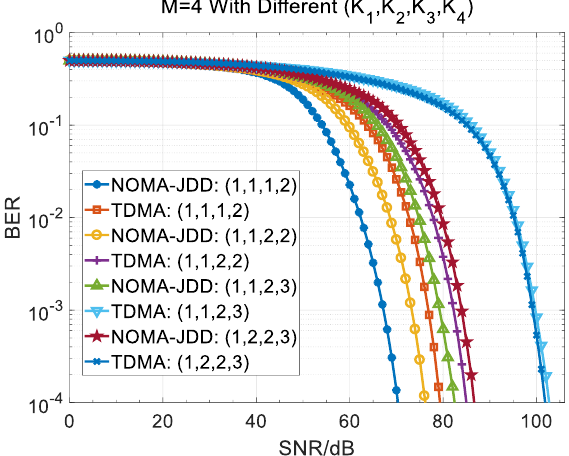
Figure 6. Four users’ average BER comparisons of our design and TDMA.